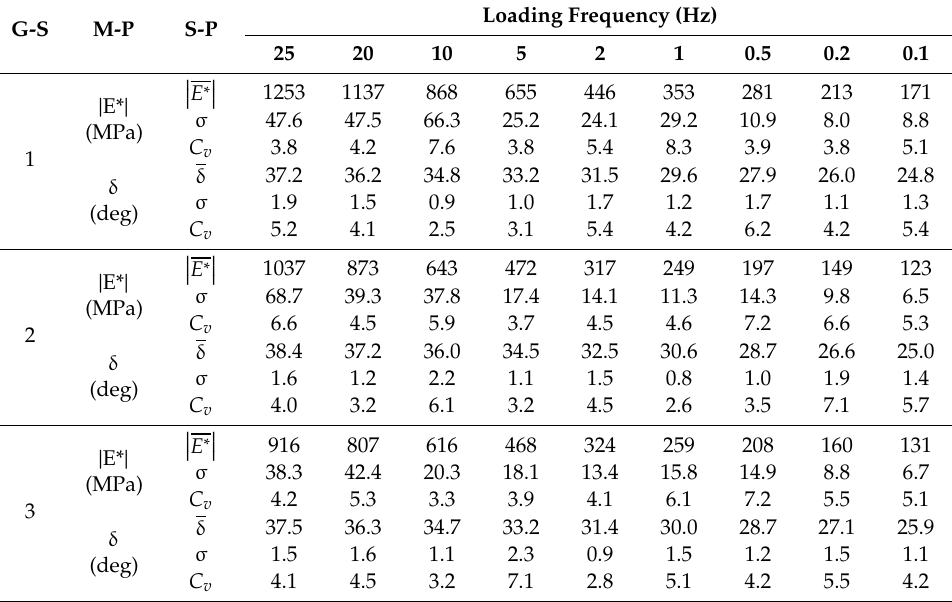
Table 6. The test results of the dynamic modulus and phase angle at 50 ◦